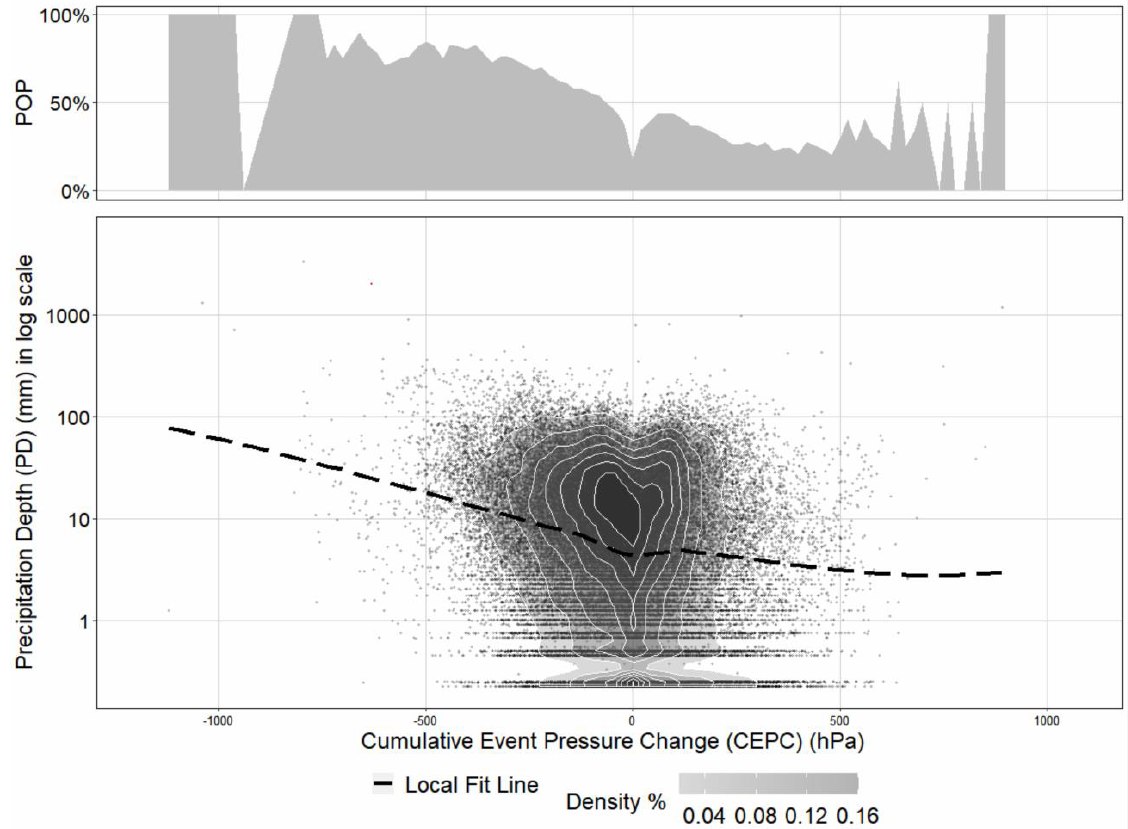
Figure 3. Relationship between precipitation depth (PD) and probability of precipitation (POP) vs. cumulative event pressure change (CEPC).